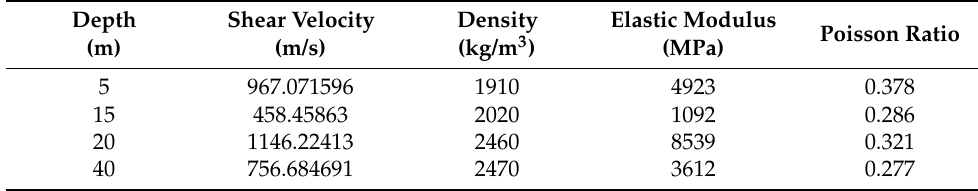
Table 2. Sites geotechnical parameters.